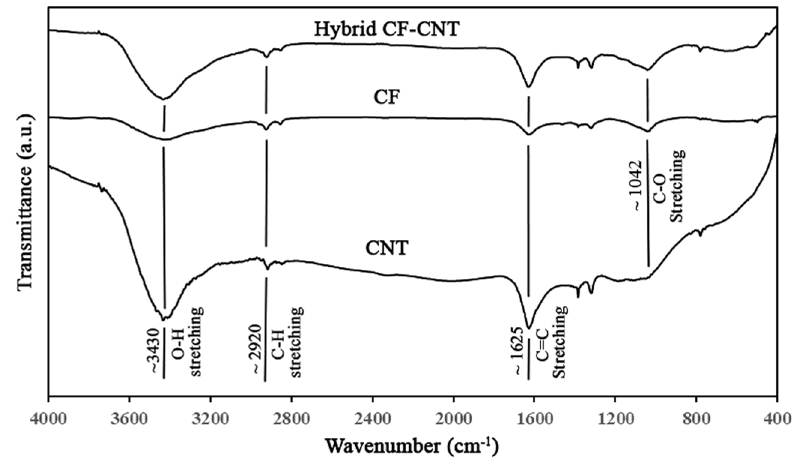
Figure 6: FT - IR spectra of CNT, CF and hybrid CF –